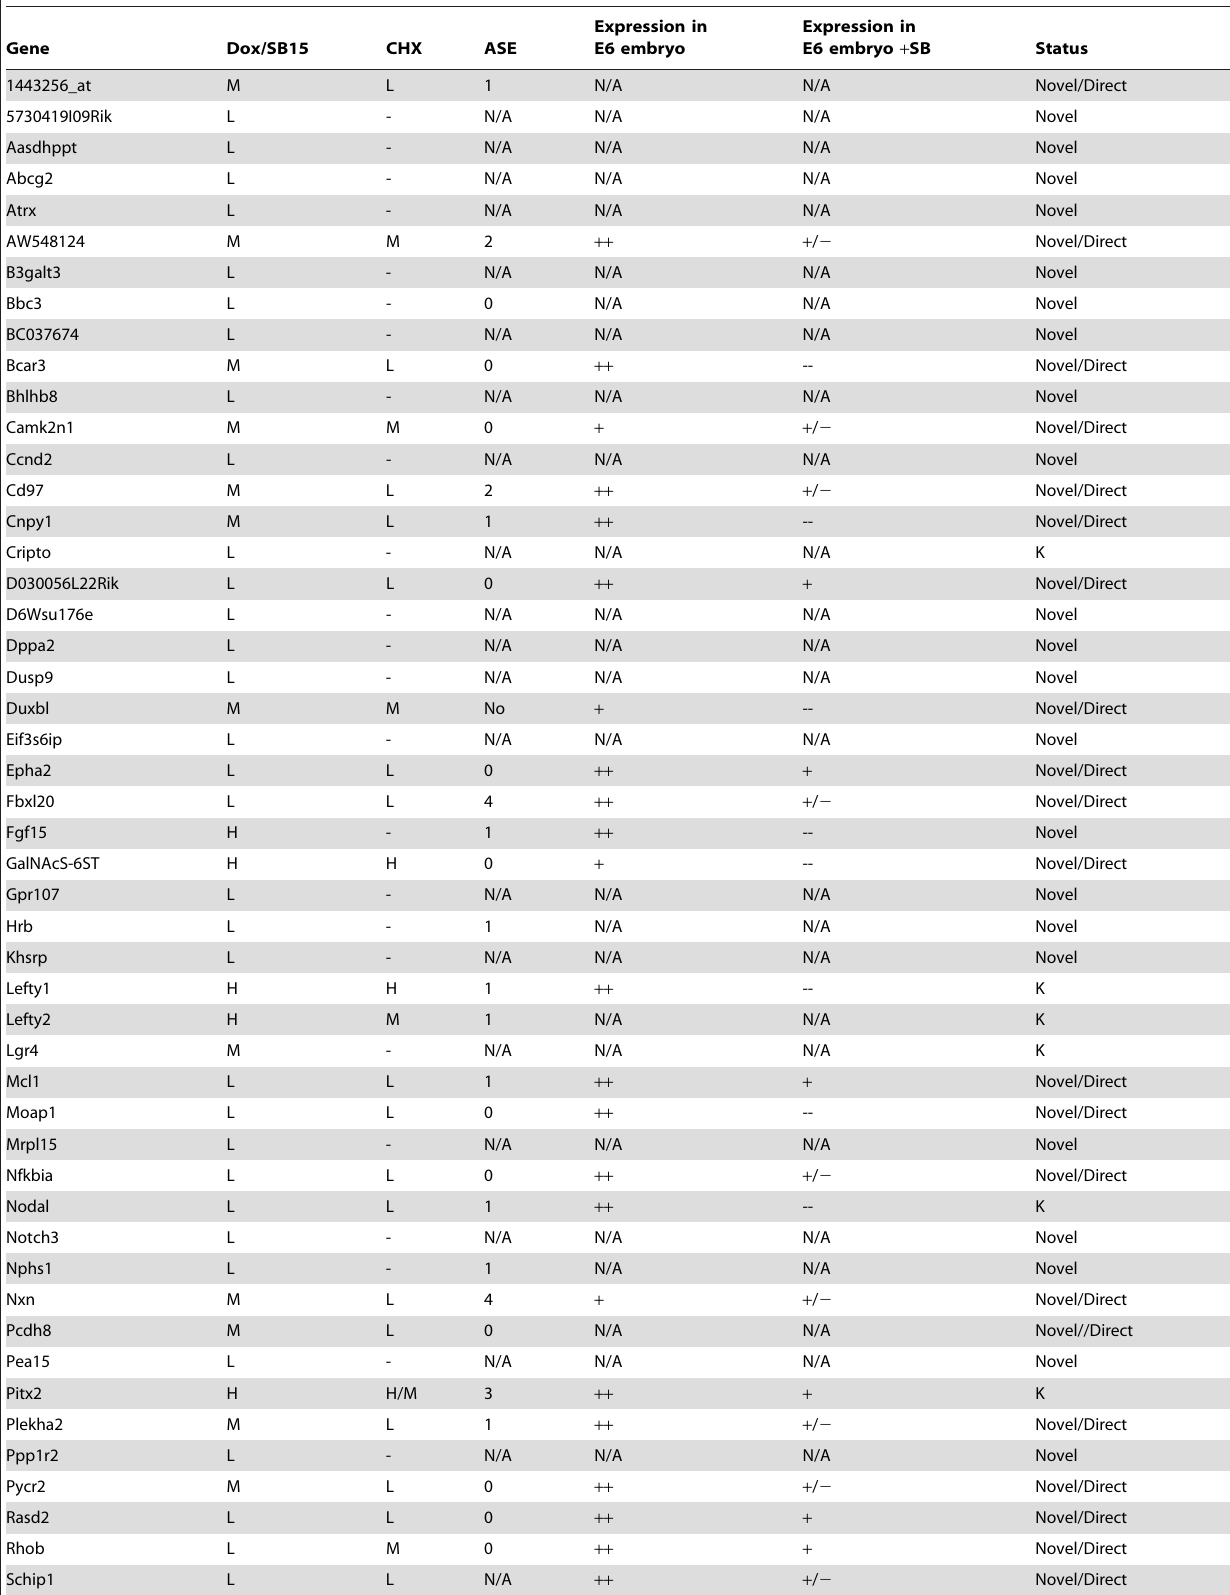
Table 4. Summary of results for 60 Nodal-Smad2/3 target genes.